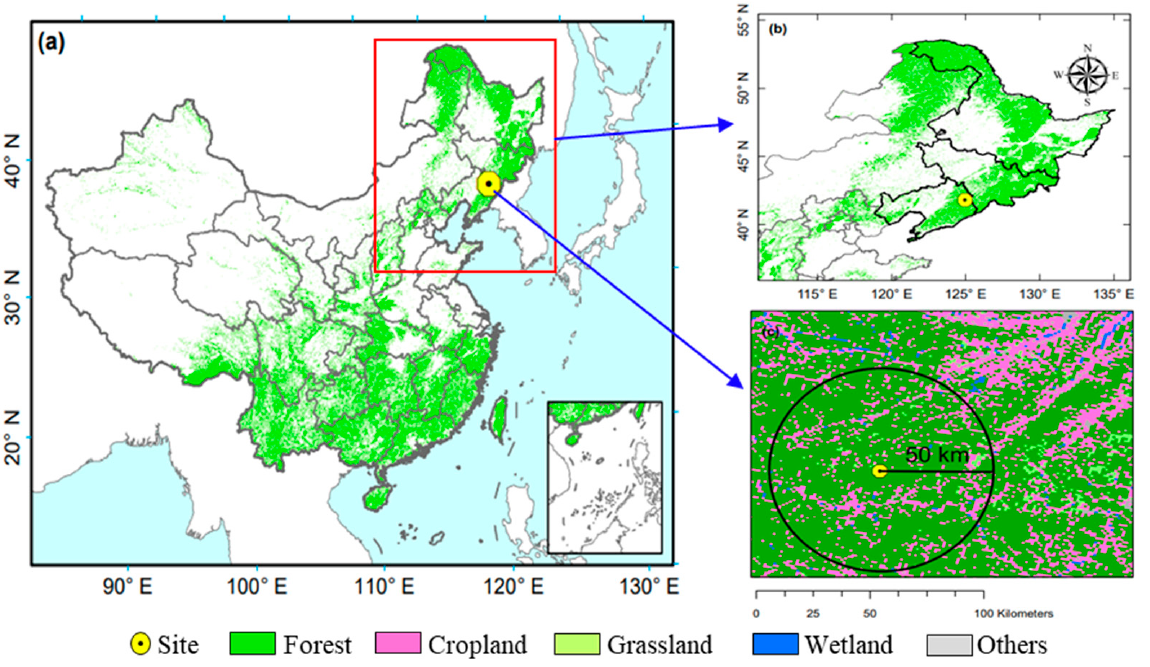
Figure 1. Location of Qingyuan Forest station in Northeast China. ( a , b ) present the location of Qingyuan Forest station in the map of China; ( c ) presents the main land use types within a 50-km radius of Qingyuan Forest station.